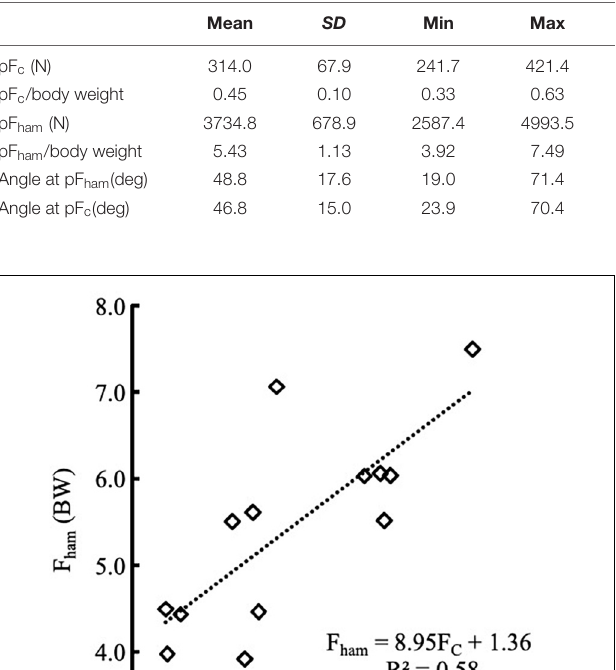
TABLE 1 | Force and angle results of the Nordic hamstring exercise.